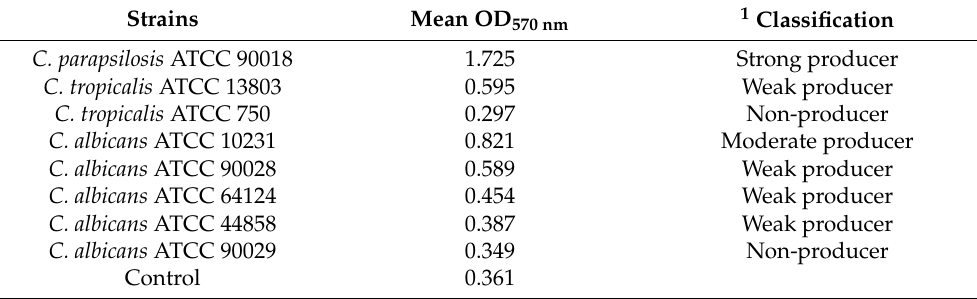
Table 4. Classification of Candida strains regarding biofilm adherence and production.